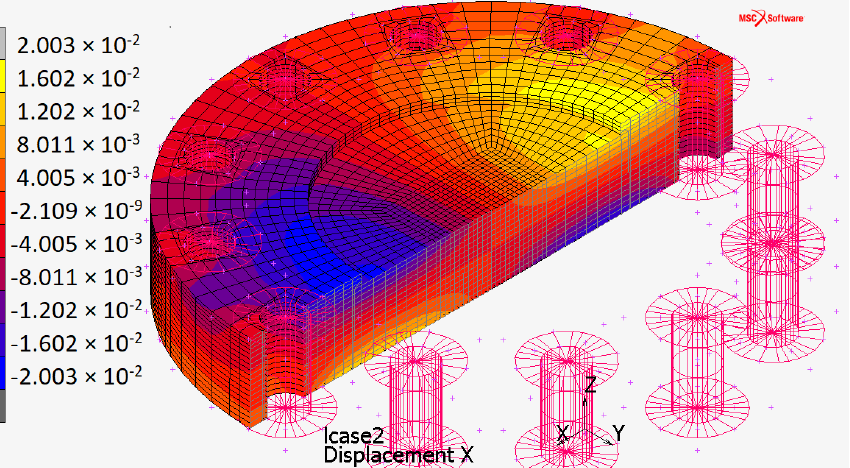
Figure 10. x -axis displacement distribution (it is the same along the y -axis, 90° rotated) for the plate when constrained by touching contact with infinitely rigid surfaces.